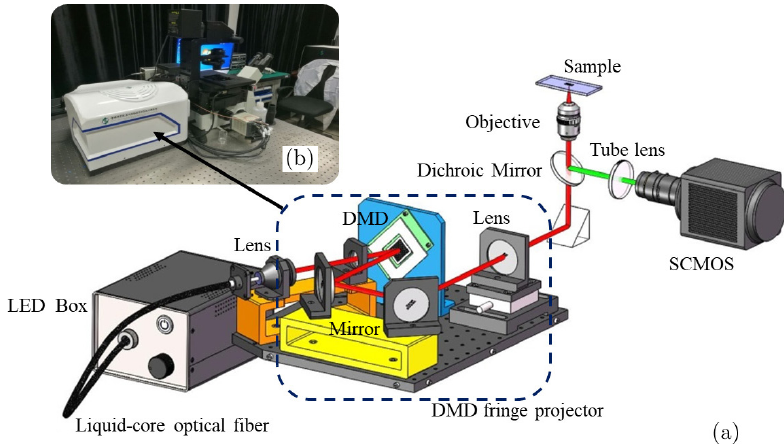
Fig. 1. Scheme (a) and photograph (b) of the DMD fringe projector attached to an inverted